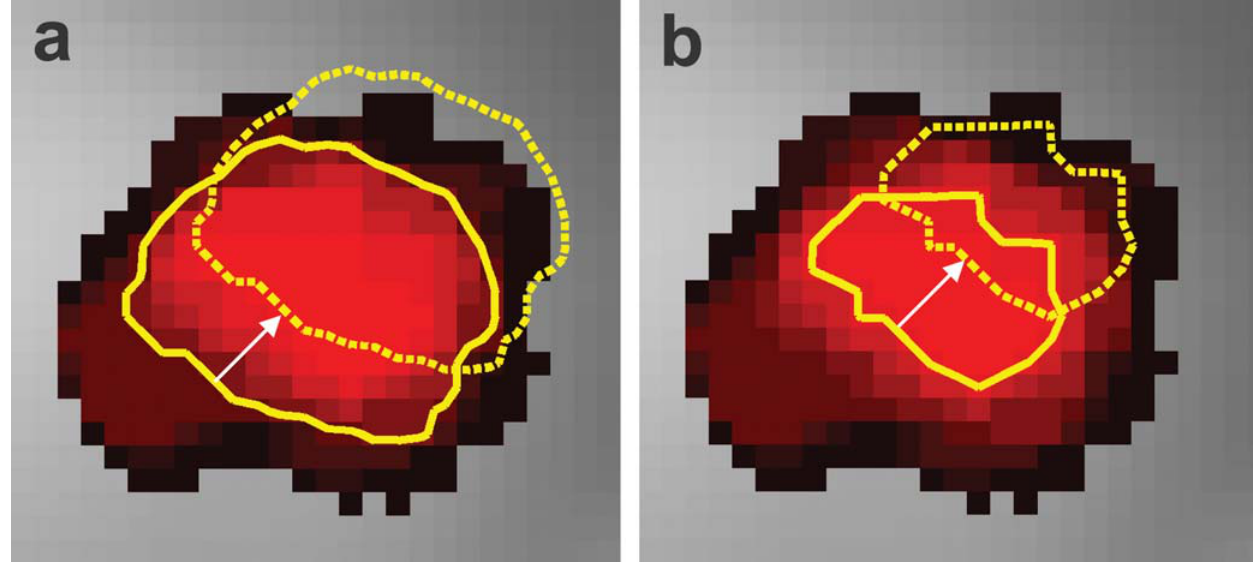
Figure 2. Simulated effect of probabilistic region of interest (ROI) definition on robustness against localization errors. In (a) and (b), axial sections through the laterobasal part (LB) of the left amygdala are shown at z= 2 29 (MNI coordinate system). Probabilities to belong to LB are color coded with black=10% and pure red=100%. In (a), the probabilistic ROI is defined as the area with . =50% probability to belong to LB (solid yellow line). As a consequence of a simulated localization error which consists of a linear shift of approximately 4 mm (indicated by the white arrow) the true measured volume is localized as indicated by the dashed yellow line, containing voxels with little or no probability to belong to LB. In contrast, when restricting the ROI to voxels with 90% or 100% LB probability (b) and given an equally large localization error, the true measured volume is still entirely located within the area of LB. In this way, the robustness against localization errors could be increased, counteracting potential localization errors while still maintaining excellent anatomical